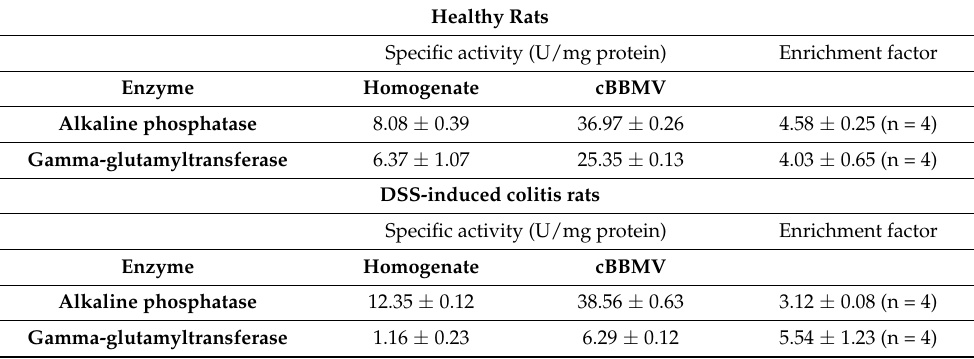
Table 1. Enzyme activity and enrichment factors in the cBBMV from healthy rat colon and DSS- induced colitis rats. Data are presented as mean ± SD, (n = 4). cBBMV, colonic brush border membrane vesicles; DSS, dextran sulfate